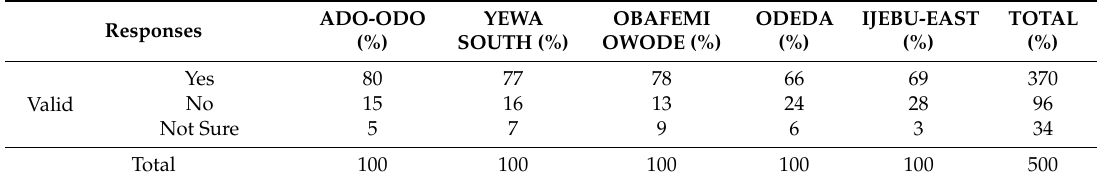
Table 12. Perceptions of the respondents on littering.